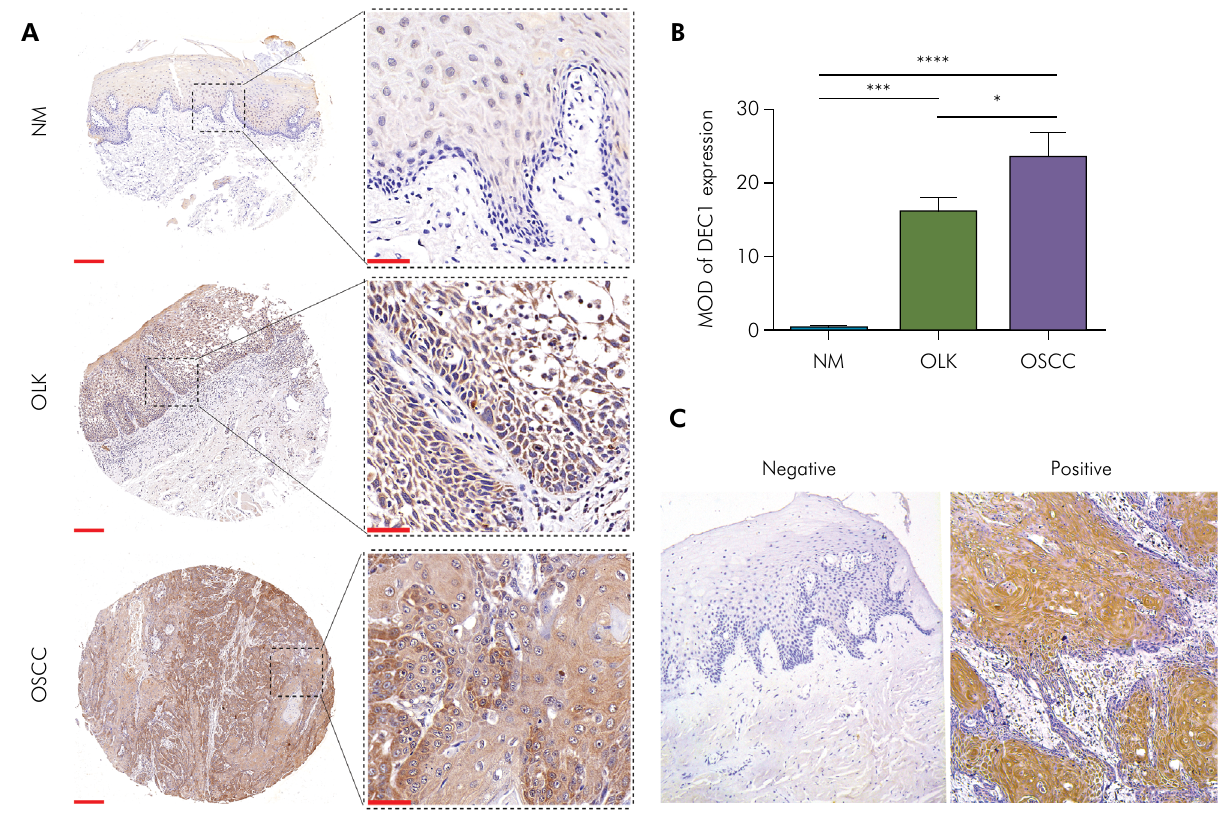
Figure 1. Immunohistochemical expression of DEC1 in oral normal mucosa (NM), oral leukoplakia (OLK) and oral squamous cell carcinoma (OSCC): (A) DEC1 immunohistochemical staining was observed in both the cytoplasm and nucleus and was successively increased in NM, OLK and OSCC. Scale bar (left side) = 200 μm, scale bar (right side) = 50 μm. (B) The MOD of DEC1 expression increased in turn, and the difference was statistically significant. The difference between NM and OSCC was the most obvious, followed by differences between NM and OLK, and OLK and OSCC. *indicates p <0 .05, *** indicates p < 0.001, ****indicates p < 0.0001, the bar on the column refers to SEM: Structural Equation Modeling.